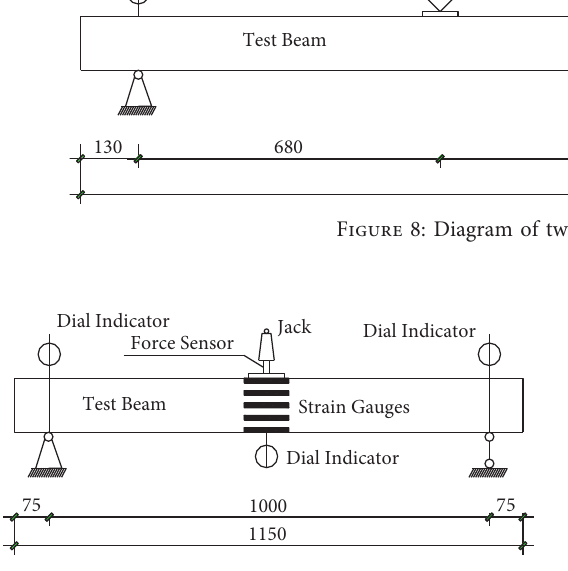
10: Shear test device for full-size